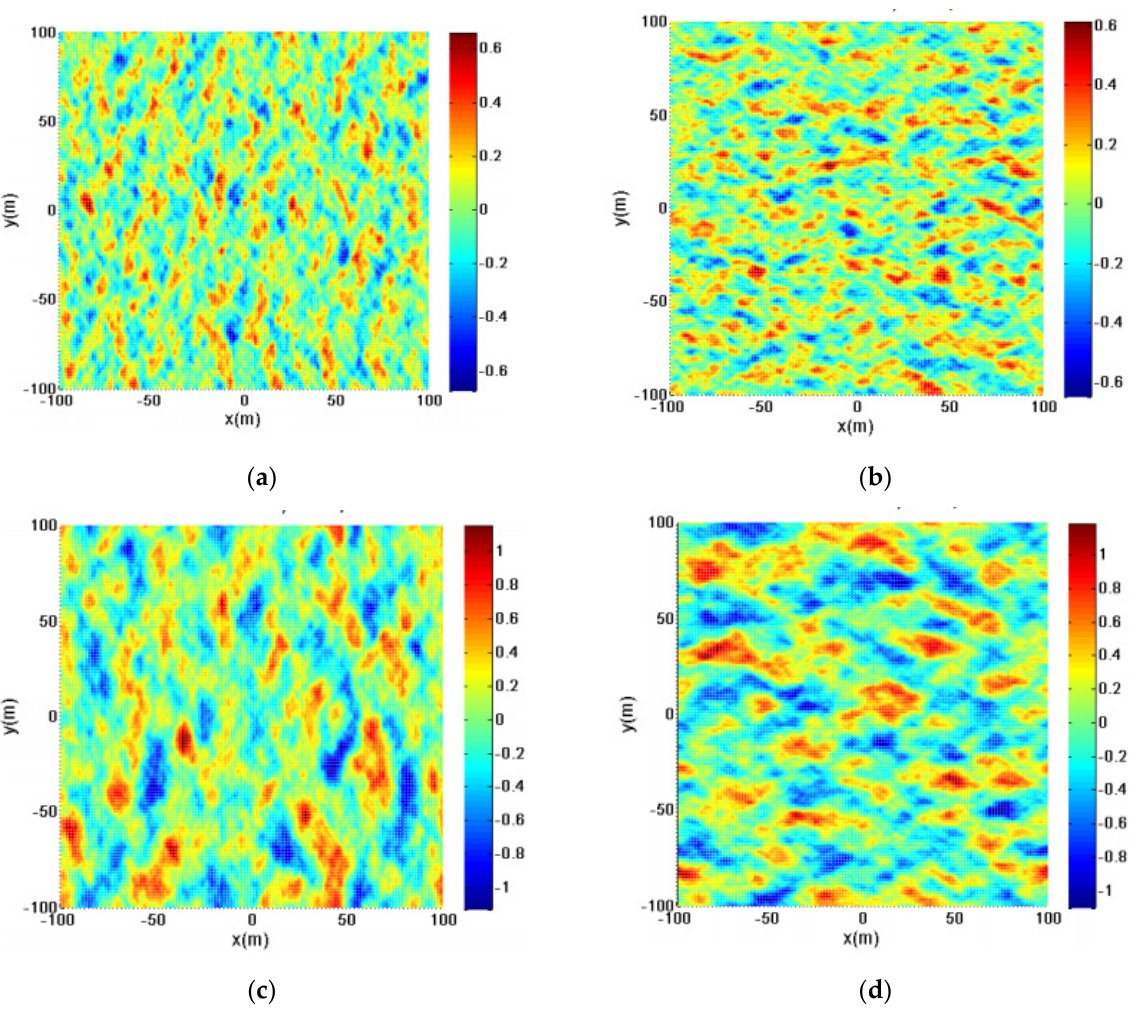
Figure 2. Geometric model of 3D sea surface: ( a ) U = 5 m / s , ϕ w = 0 o ; ( b ) U = 5 m / s , ϕ w = 90 o ; . ( c ) U = 7 m / s , ϕ w = 0 o ; ( d ) U = 7 m / s , ϕ w = 90 o